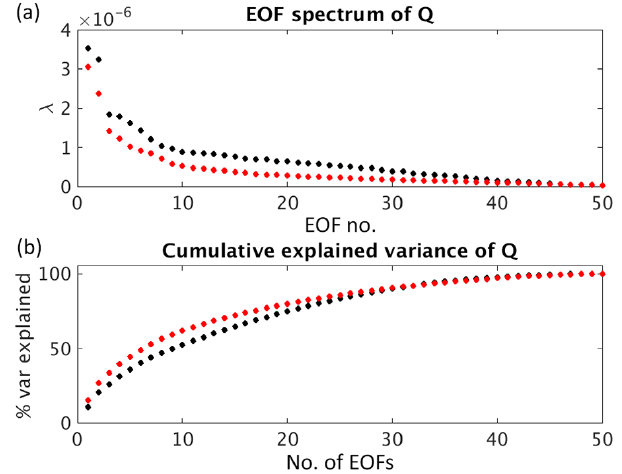
Figure 6. (a) The eigenspectrum of ˆ Q derived from smooth (red) and unsmoothed (black) δ x . (b) The cumulative percentage vari- ances explained by the EOFs of ˆ Q